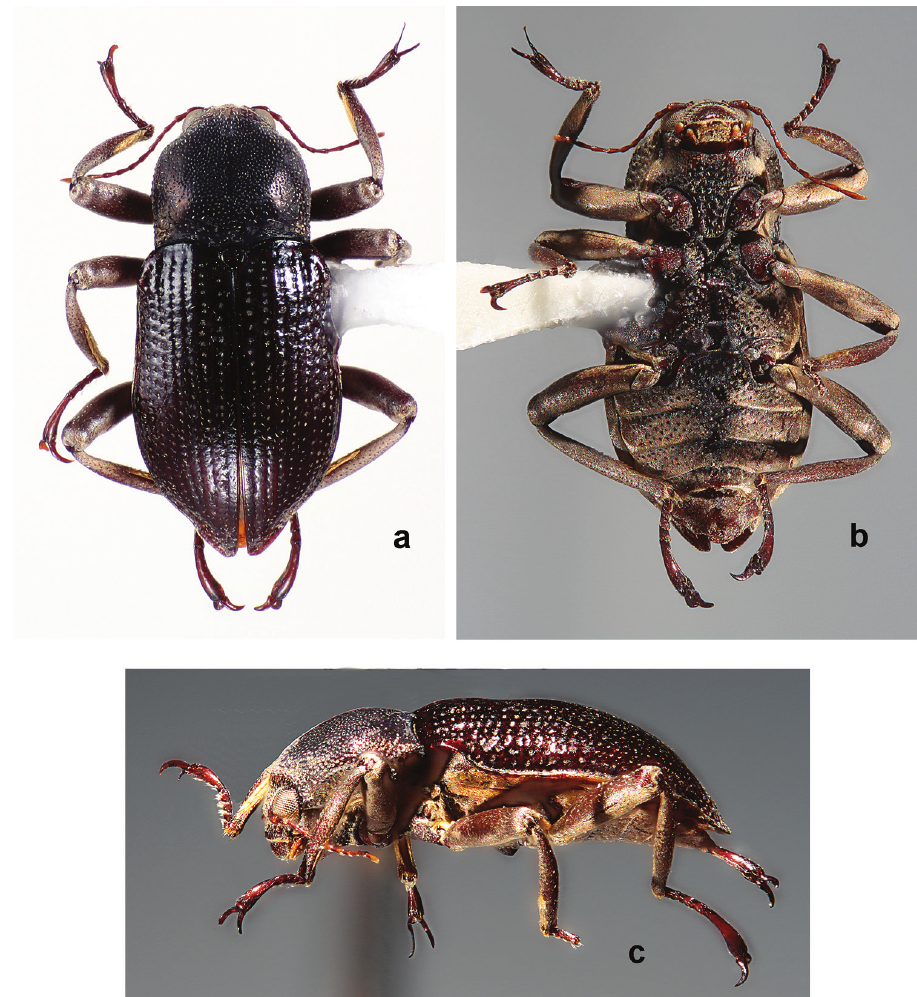
Figure 4. Amazonopsis theranyi sp. n., paratype male from Venezuela, length 4.05 mm a Dorsal habitus b Ventral habitus c Lateral